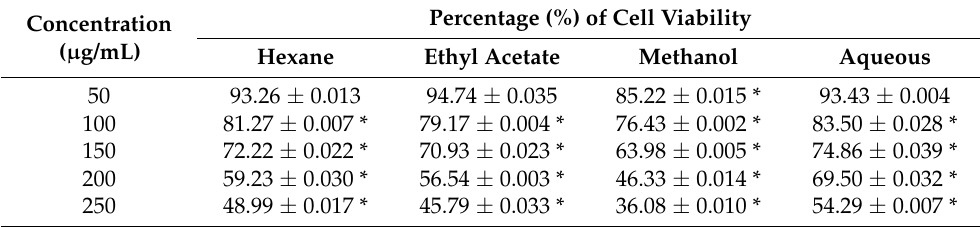
Table 5. Anticancer activity of F. arabica extracts against oral cancer KB-3-1 cell